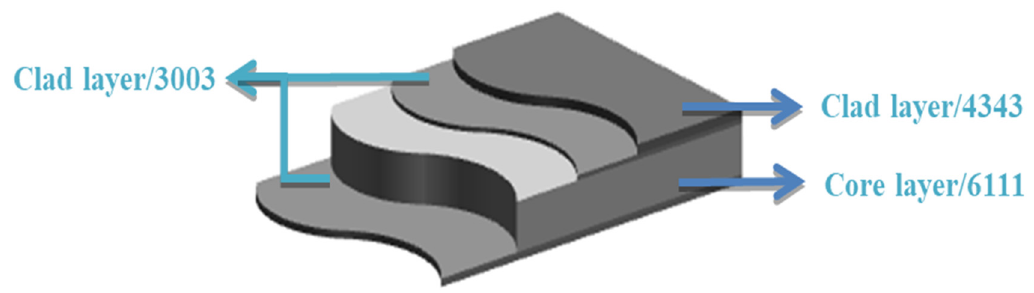
Figure 1. Schematic illustration of the four-layer composite sheet.